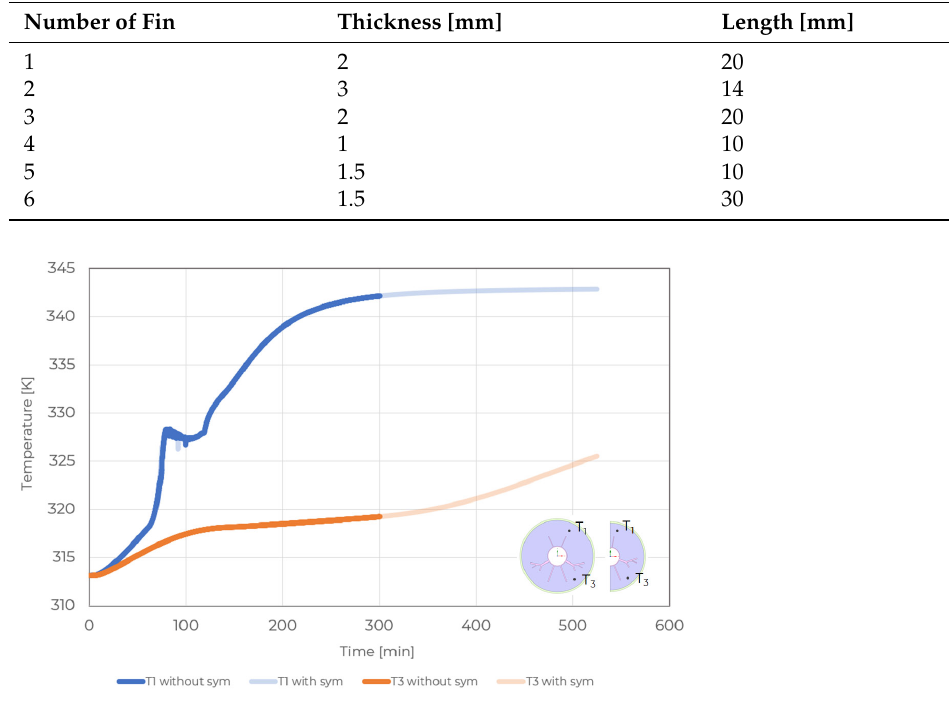
Figure 2. Comparison of the computational model with and without symmetry. Table 2. Input parameters variability